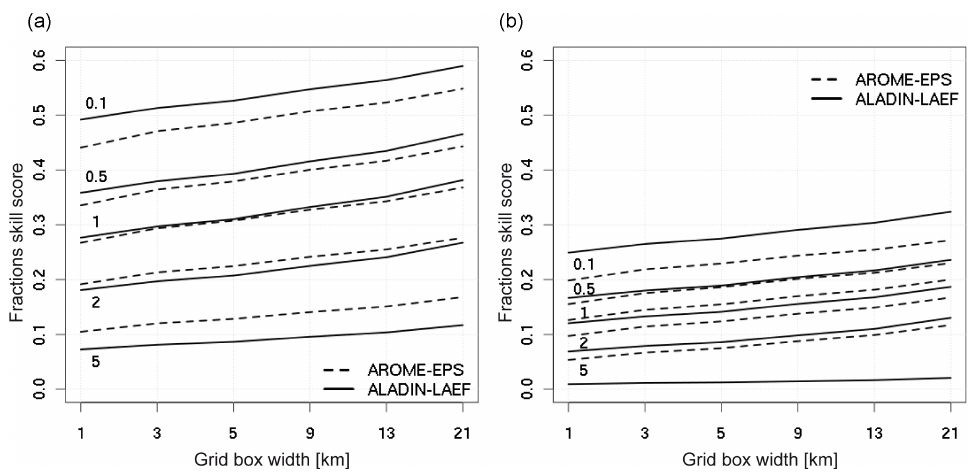
Figure 10. FSSs for (a) strong synoptic forcing, and (b) weak synoptic forcing of AROME-EPS (dashed) and ALADIN-LAEF (solid line) for the region Austria. Numbers denote the precipitation thresholds (mm). The values represent averages for all hours of lead time.